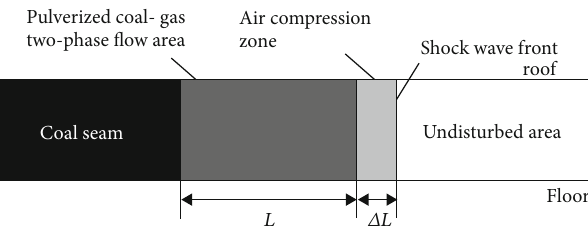
Figure 7: The model of outburst wave in the roadway.